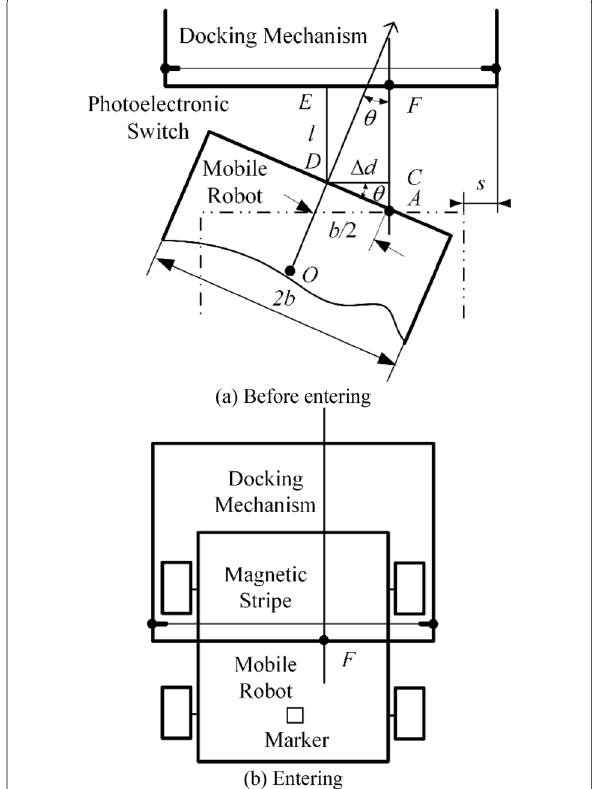
Figure 8 Magnetic navigation positioning principle diagram